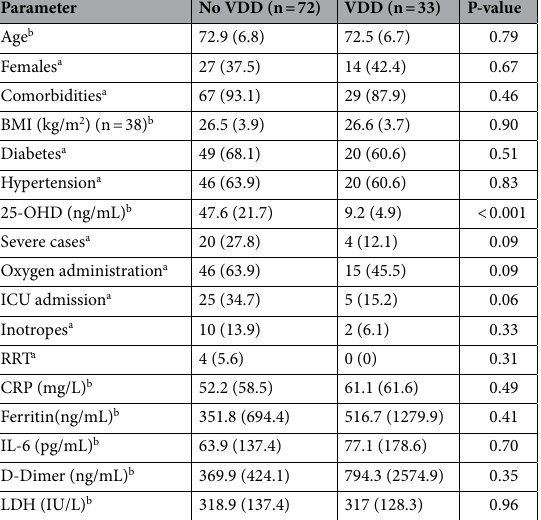
Table 2. Outcomes of elderly hospitalized COVID-19 patients (age ≥ 65 years) with or without VDD, data presented as number (percentage) for categorical a and mean (SD) for continuous variables b .